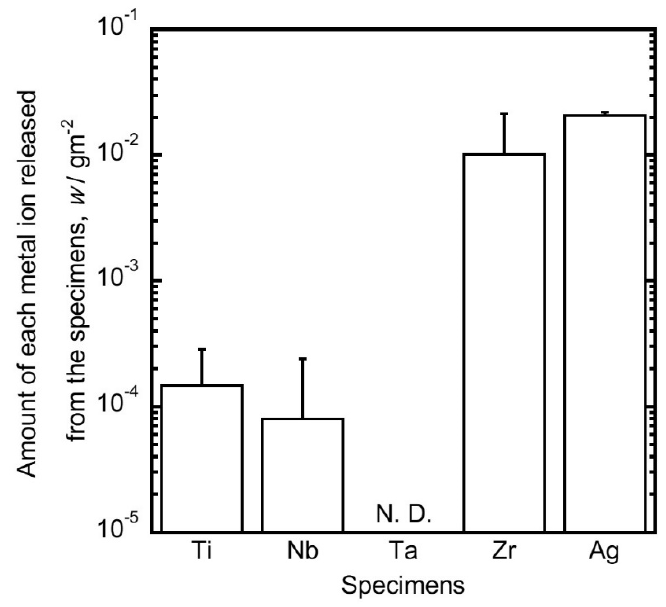
Figure 3. The amount of metal ions released from specimens during 72 h immersion in Hanks’ solution. Data are shown as the mean ± SD. N. D.: not detected.